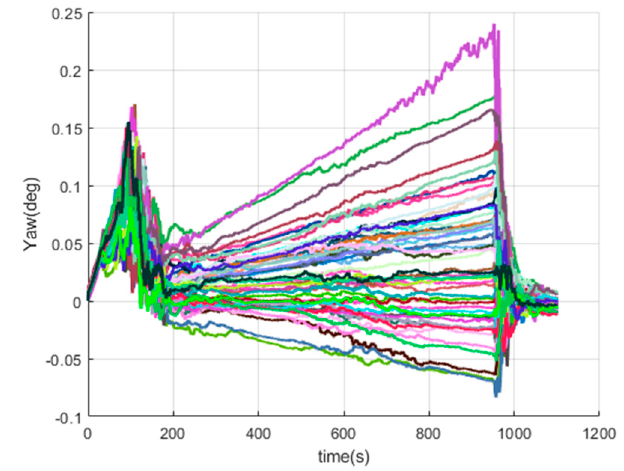
Figure 17. The yaw errors of SINS/GPS in the LCEF frame.